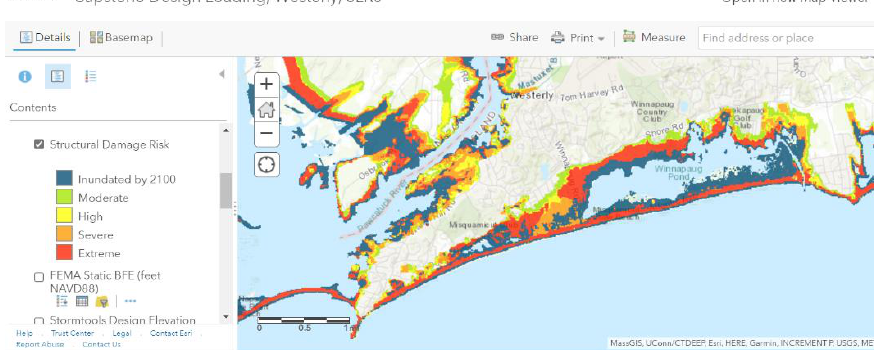
Figure 14. Structural damage risk, 100 yr storm, 0 ft sea level rise ( upper panel) and 5 ft SLR ( lower panel).